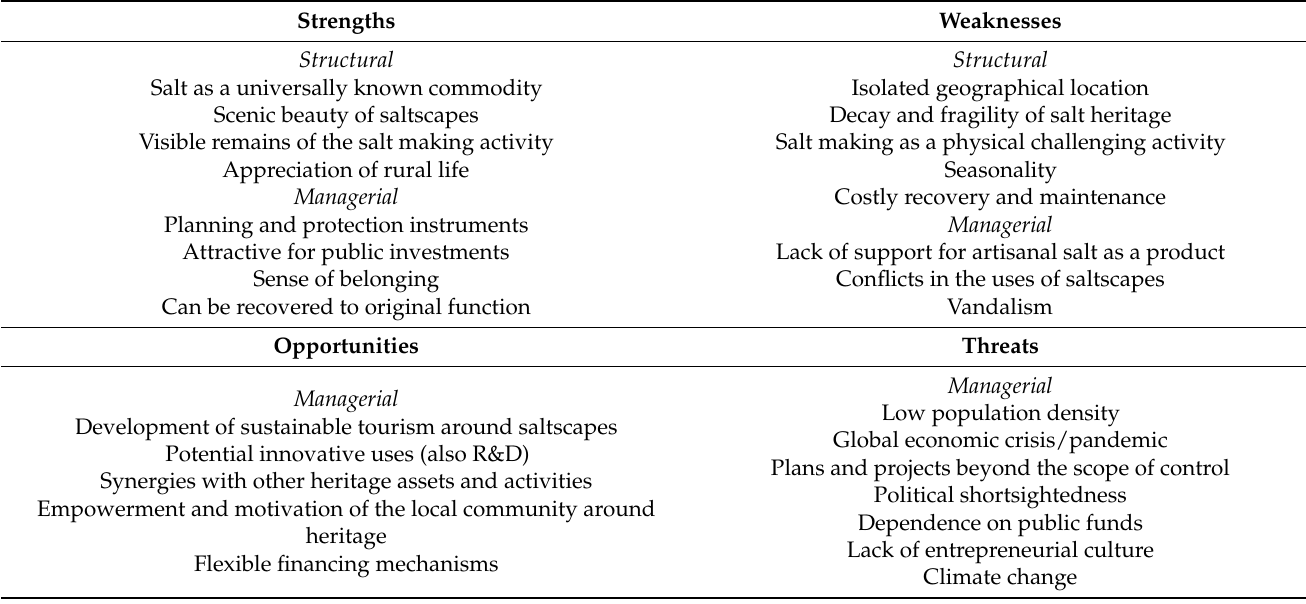
Table 3. SWOT analysis of salt heritage and